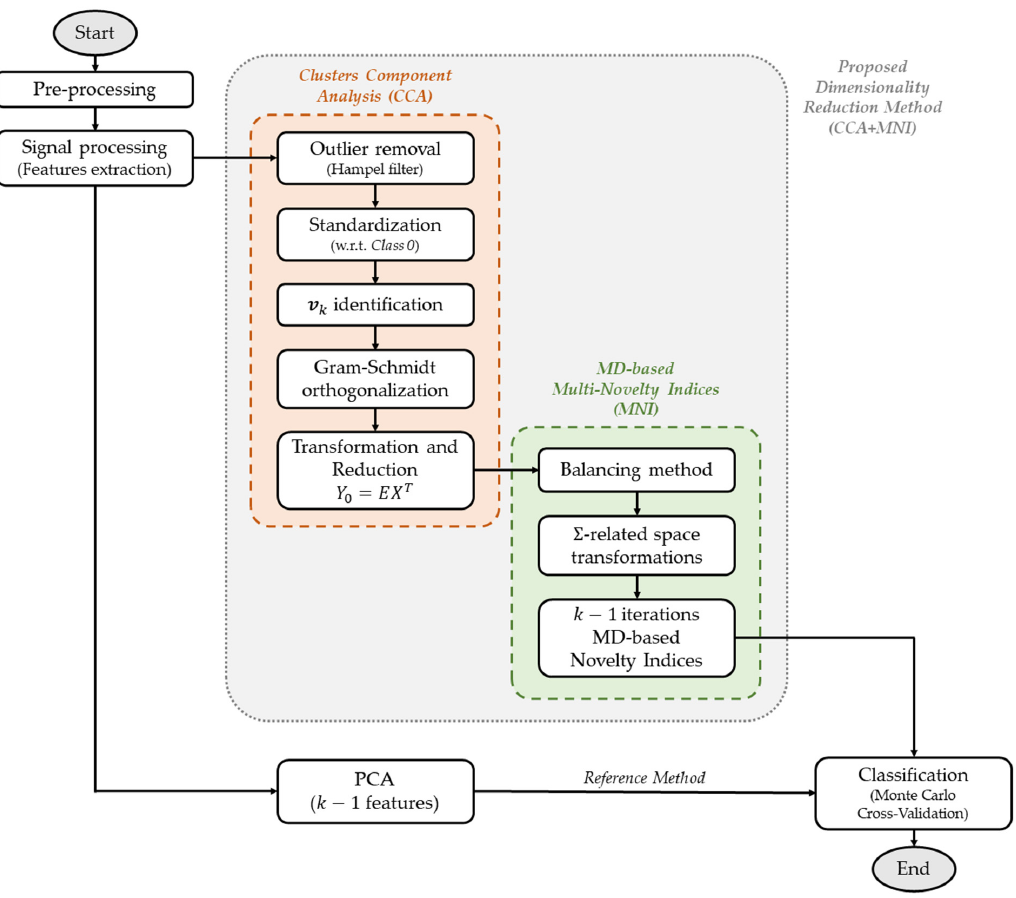
Figure 3. Flowchart summarizing the proposed and reference methods. Please note that CCA could also be applied independently.